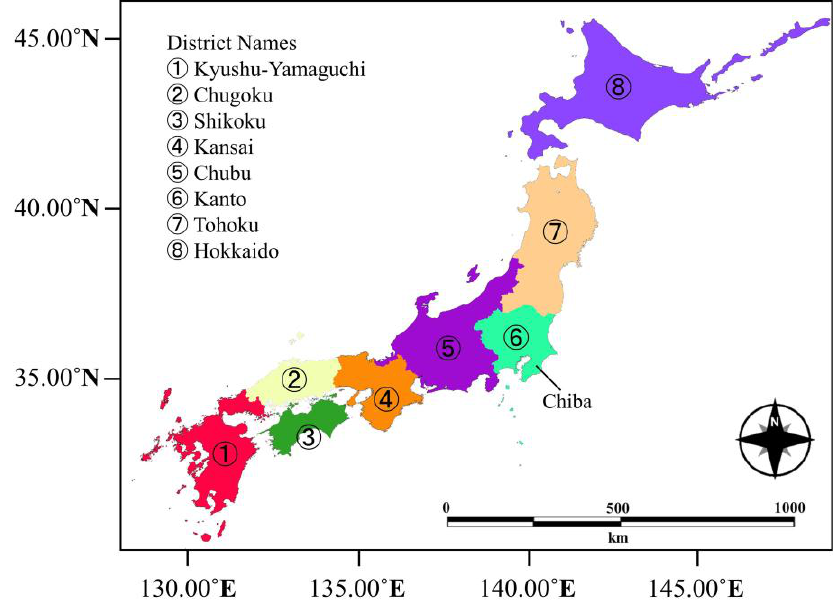
Figure 1. Study Area, Japan and its eight major